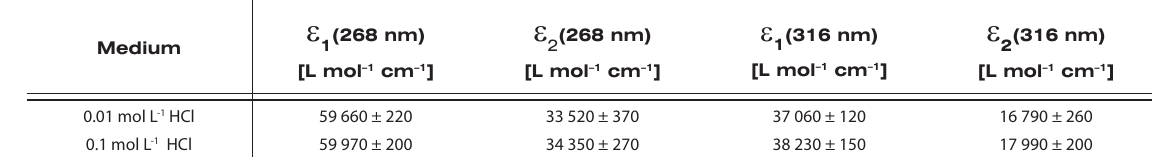
Figure 5. Absorbance-pH curves of chelerythrine (c = 6.5 µmol L -1 ) in = 6.5 µmol L -1 , c CHE CHE HCl = 0.01 mol L -1 , pH adjusted by NaOH). Curve - pH: 1 – 3.16; the presence of mineral acids at c = 0.01 mol L -1 measured at λ = 268 nm, neutralization with NaOH (a) or TRIS (b). Curve – acid: 1 – HCl; 2 – HNO ; 3 – H SO ; 4 – H PO 3 2 4 3 and ε and their average standard deviation over the whole data set for the charged iminium Q + ( ε ) 1 2 1 ) forms of chelerythrine calculated using a numerical interpretation of 2 = 6.5 µmol L -1 , c = 0.01 or 0.1 mol L -1 , pH adjusted by NaOH). CHE HCl